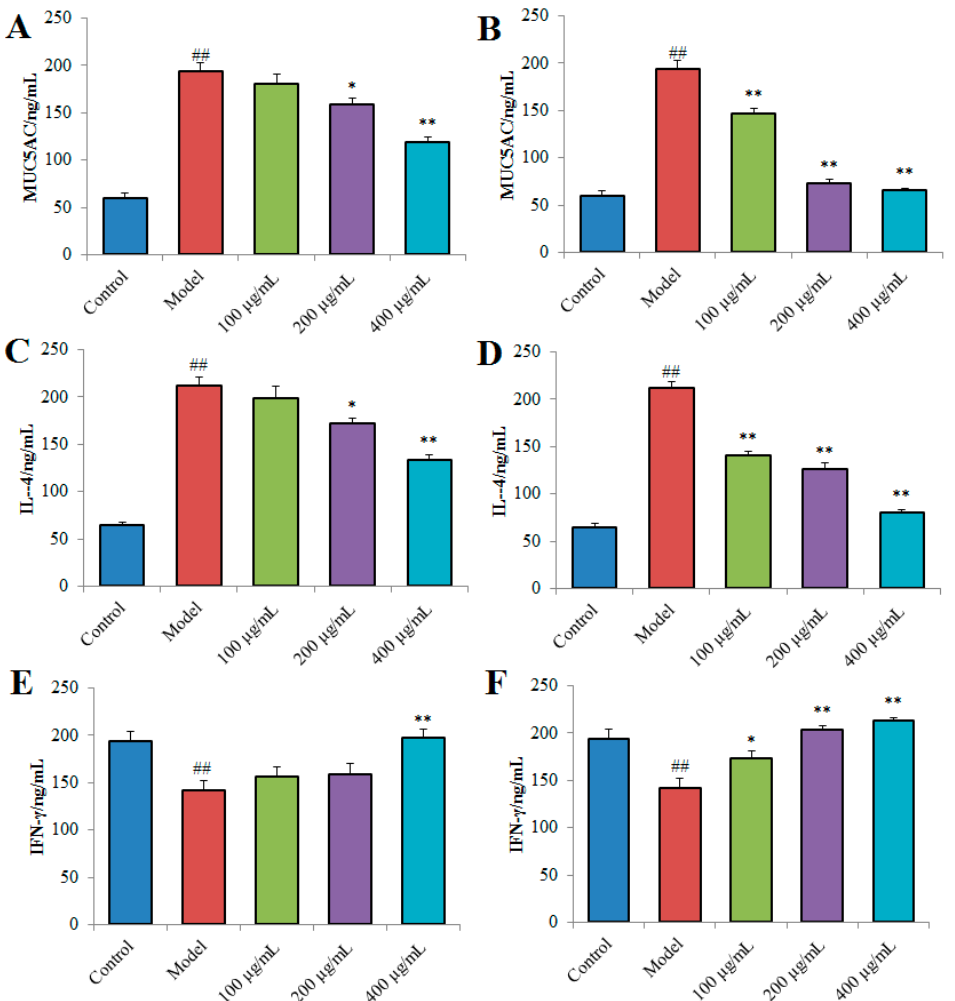
Figure 8. E ff ects of neutral fraction of total polysaccharides-II (TPN-II) ( A ), ( C ) and ( E ) and acidic fraction of total polysaccharides-II (TPA-II) ( B ), ( D ) and ( F ) on the levels of mucin-5 subtype AC (MUC5AC), interleukin-4 (IL-4) and Interferon- γ (IFN- γ ) in the culture supernatants of human airway epithelial cells (NCI-H292). ## p < 0.01, compared with control group; * p < 0.05, ** p < 0.01, compared with model group.